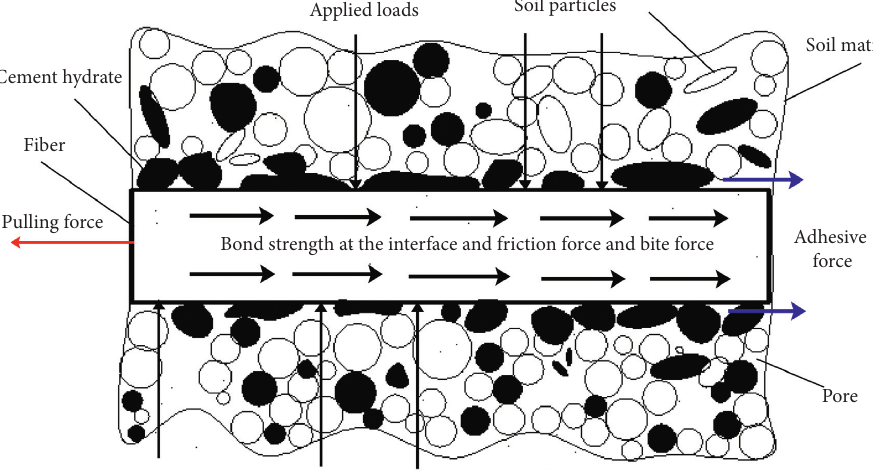
Figure 20: Interfacial